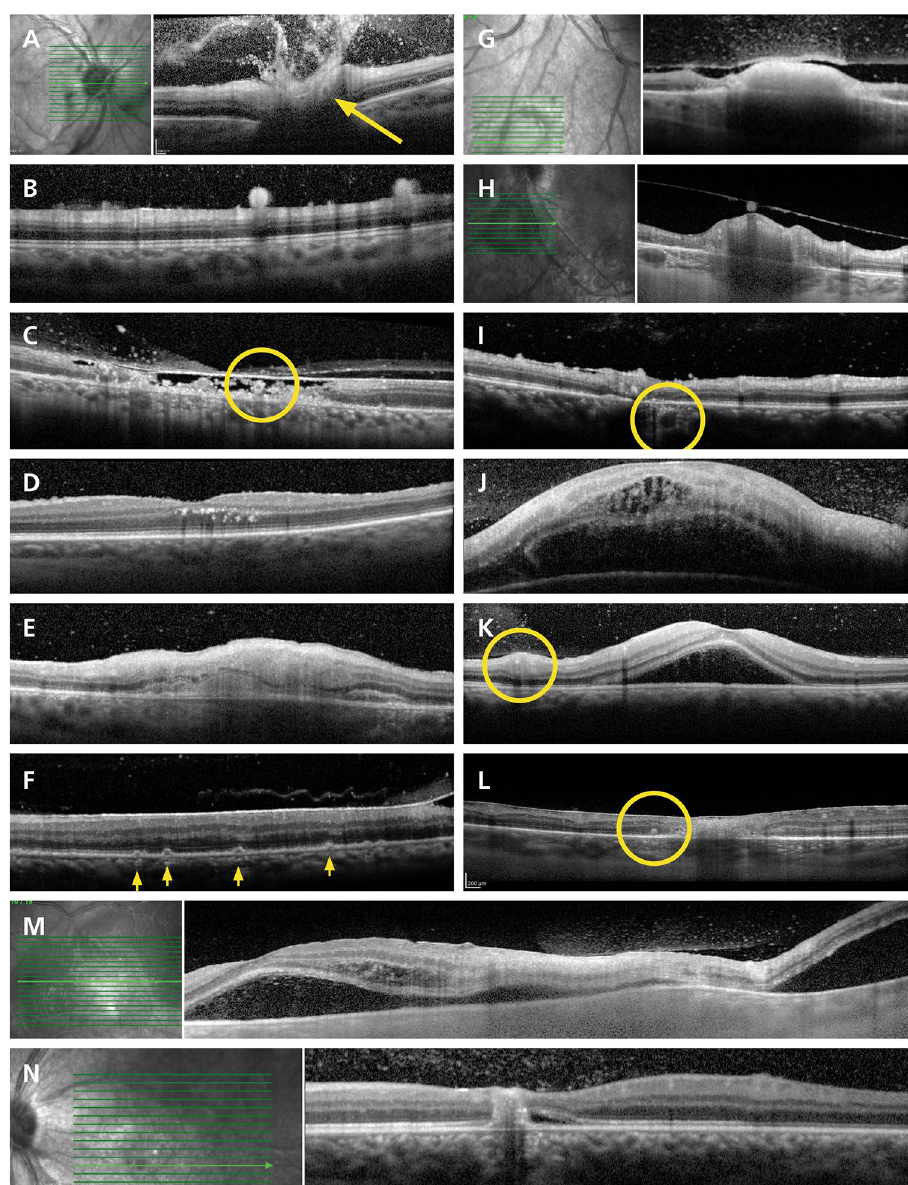
Figure 1. Representative signs of active toxoplasmic retinochoroiditis by spectral domain optical coherence tomography. ( A ) Hyperreflective dots in the vitreous cavity overlying the optic disc (zone 1, primary, IgM-negative); note perivascular hyperreflectivity (arrow); ( B ) Large hyperreflective deposits (190 µm) at vitreoretinal interface (zone 2, recurrent, IgM-negative); ( C ) Hyperreflective blood vessel (circled, identified on en-face image) within a hyporeflective retinal space (HIV-positive, zone 2, recurrent, IgM-negative); ( D ) Intraretinal hyperreflective dots in the outer plexiform and outer nuclear layers (zone 2, primary, IgM-positive); ( E ) “Ribbon” appearance of hyporeflective outer nuclear layer between thickened hyperreflective photoreceptor-RPE complex and hyperreflective inner nuclear layer (zone 1, recurrent, IgM-negative); ( F ) RPE “bumps” (arrows), (HIV-positive, zone 2, recurrent, IgM-negative); ( G ) Hyperreflective dots in the vitreous cavity, thickened posterior hyaloid with partial posterior vitreous detachment; retinal thickening with full-thickness hyperreflectivity and adjacent disorganization of the retinal layers; adjacent RPE thickening, choroidal hyporeflectivity and thickening (zone 2, primary, IgM-negative); ( H ) Large hyperreflective deposit on posterior hyaloid face (zone 2, recurrent, IgM-negative); note thickened hyperreflective retina with choroidal hyporeflectivity and thickening; ( I ) Hyperreflective dots surrounding choroidal vessel (circled); hyperreflective dots on internal limiting membrane and disorganized retinal layers (zone 2, recurrent, IgM-negative); ( J ) Gross macular thickening with hyperreflective dots and intraretinal fluid in the outer plexiform and outer nuclear layers, subretinal fluid and bowing of RPE-Bruch’s membrane complex (zone 1, primary, IgM-negative); ( K ) Subfoveal fluid and hyperreflective dots in the vitreous cavity overlying a blood vessel (circled) (zone 2, primary, IgM-negative); ( L ) Round body in outer nuclear layer (circled), with adjacent retinal hyperreflectivity and disorganization of retinal layers (zone 2, primary, IgM- positive); ( M ) Subfoveal fluid with hyperreflective retinal dots, outer plexiform and outer nuclear layer fluid and hyperreflective dots, retinal hyperreflectivity, bowing of RPE-Bruch’s membrane complex, overlying hyperreflective dots in the vitreous cavity and partial separation of posterior hyaloid (zone 2, primary, IgM-negative); ( N ) Hyperreflective dots in the vitreous cavity, disorganization of retinal layers, RPE thickening with subjacent choroidal hyporeflectivity and adjacent subfoveal fluid (zone 1, recurrent, IgM-negative). Abbreviations: SD-OCT = spectral domain optical coherence tomography, TRC = toxoplasmic retinochoroiditis, Ig = immunoglobulin, RPE = retinal pigment epithelial/epithelium, HIV = human immunodeficiency